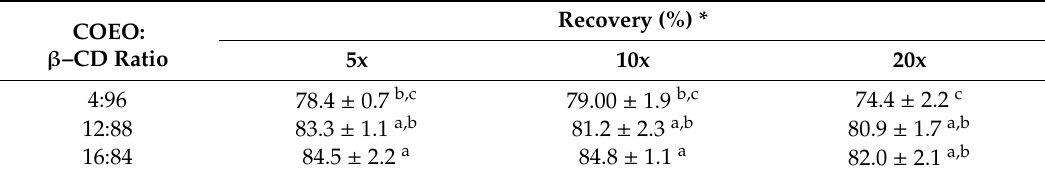
Table 1. Recovery of the powder (complex) from each concentrated orange oil (COEO) to β -cyclodextrin ( β –CD)